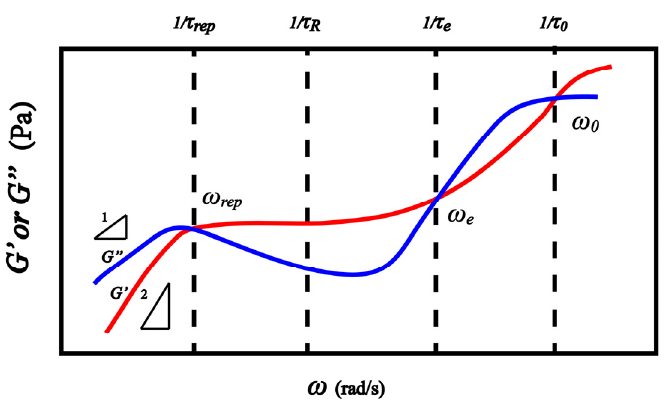
Figure 2. Sketch of dynamic frequency sweep curve of polymer chain in a wide frequency range at room temperature.